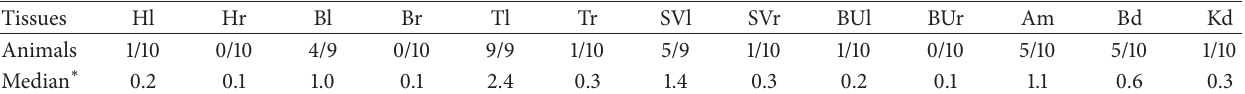
Table 3: Distribution, frequency, and intensity of inflammatory lesions in the genitourinary organs of rams experimentally infected with Actinobacillus seminis .